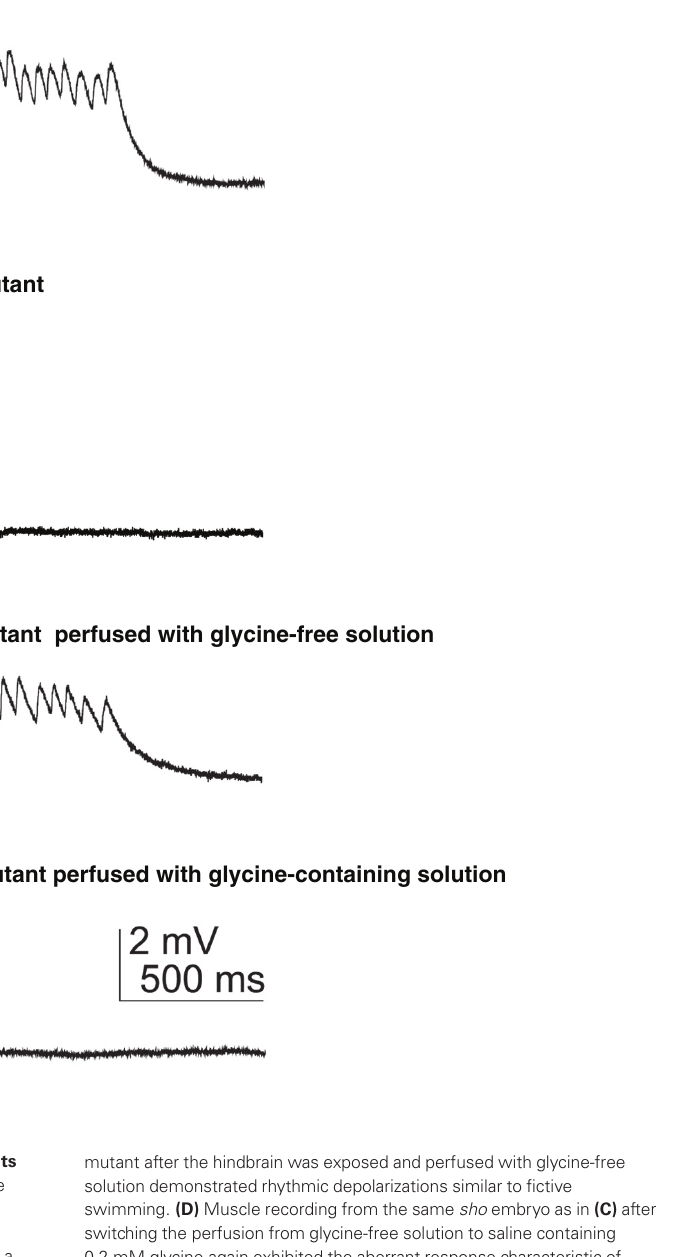
FIGURE 5 | The aberrant motor response of shocked ( slc6a5 ) mutants defective in GlyT1 is due to high external glycine. (A) Muscle voltage recording from a wild-type embryo showed normal fi ctive swimming in response to mechanosensory stimulation. Arrows indicate the time of stimulation. (B) Muscle recording from a sho mutant embryo displaying a large, nonrhythmic depolarization. (C) Muscle recording from a sho